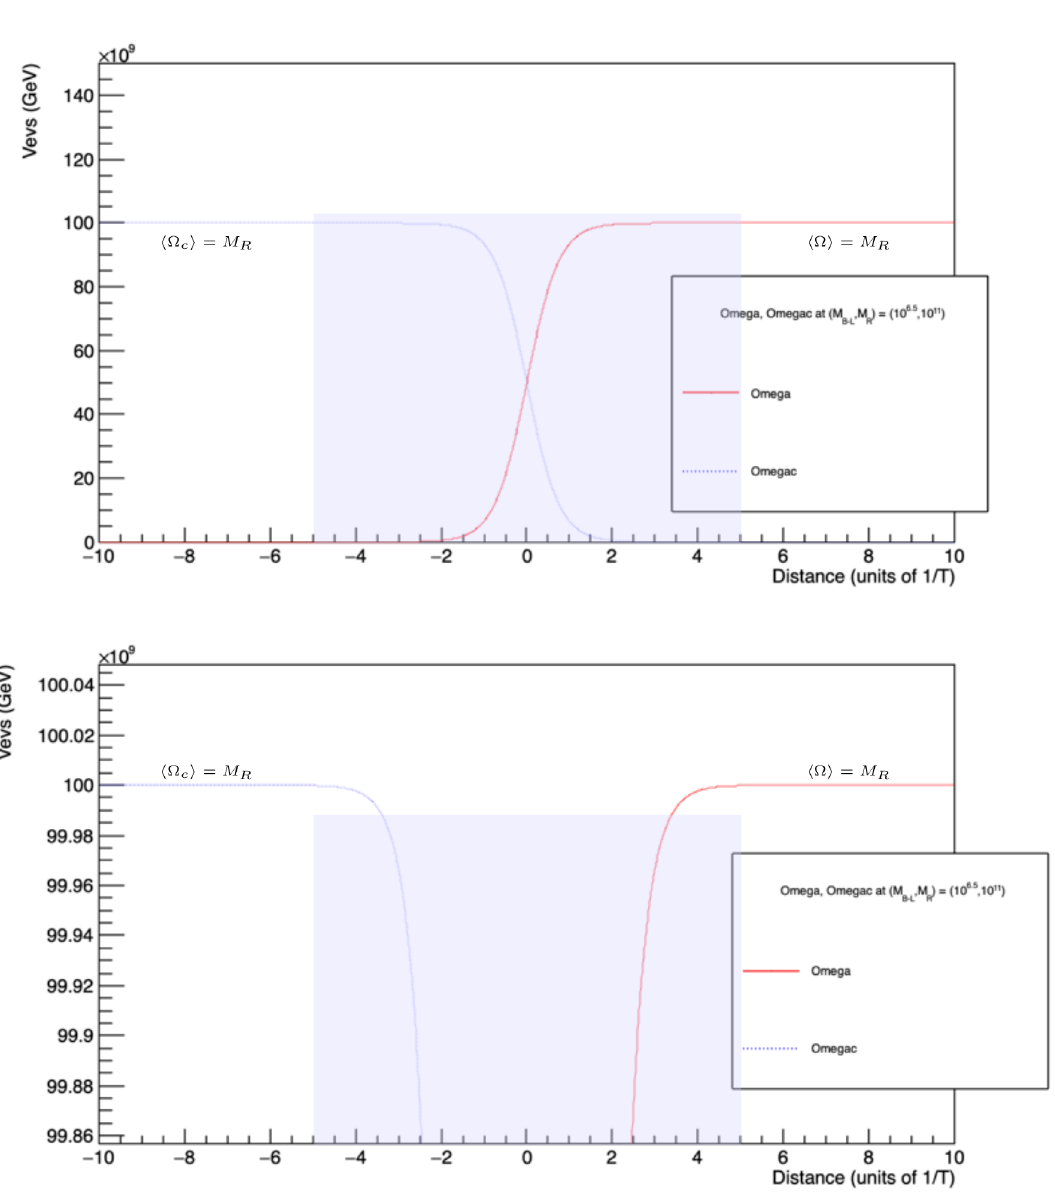
Figure 1 . Above: plots of vacuum expectation values ω , ω c as a function of the distance x , in units of 1 /T , from the domain wall, plotted for T = M B − L = 10 6 . 5 GeV , M R = 10 11 GeV , L = 5 , λ ∼ L − 2 = 0 . 04 and the choice of the other parameters, a = − 1 . 5 , α = 0 . 006 , µ 11 = 0 . 7 M R , µ 22 = 0 . 7 M R , µ 1 = 0 . 2 α 2 M R , µ 2 = 0 . 3 α 2 M R , µ 3 = 0 . 5 α 2 M R , β 3 = − 0 . 5 , µ 4 = 1 . 5 α 2 M R , β 4 = 1 . 2 , µ 5 = 0 . 1 α 2 M R , β 5 = − 1 . 4 . The domain wall stretches from − L to L . Below: the same plot magnfied, showing the gradual drop of the vevs of ω , ω c just inside the wall around x = ± L